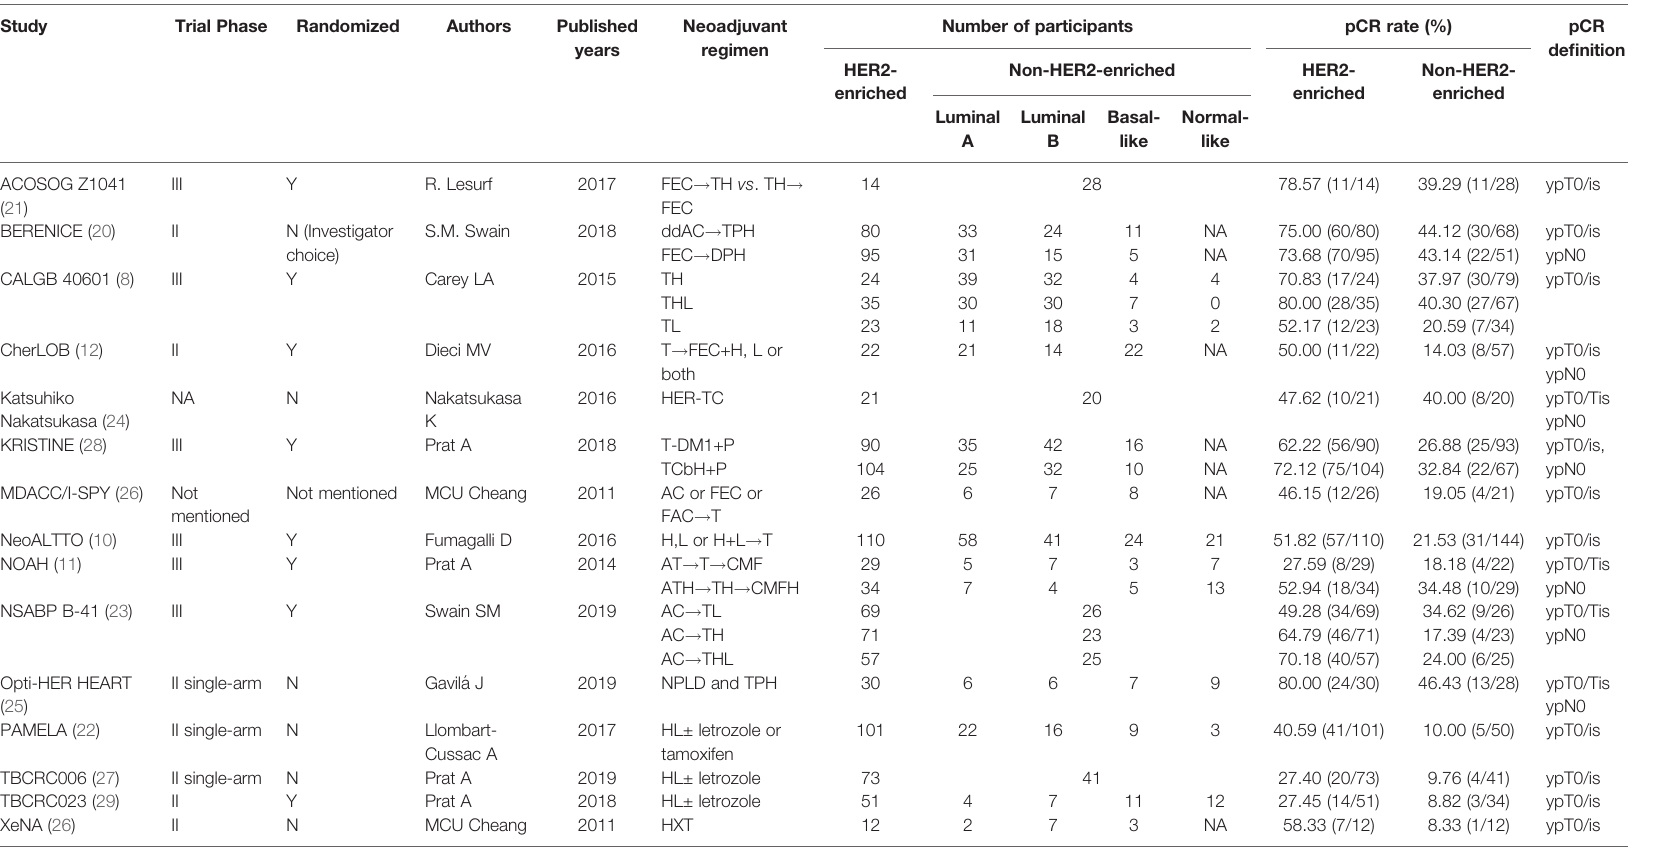
TABLE 1 | Baseline characteristics of included